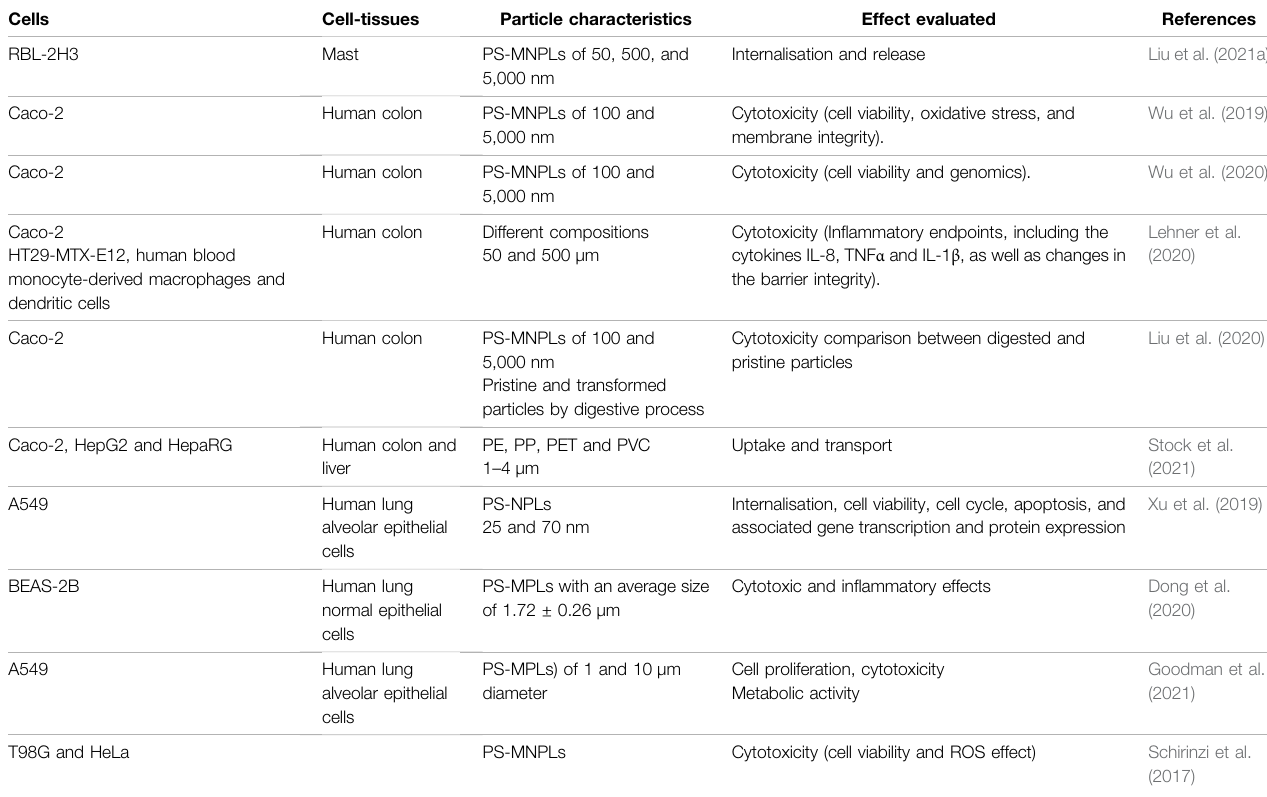
TABLE 3 | Selection of toxicological studies using human